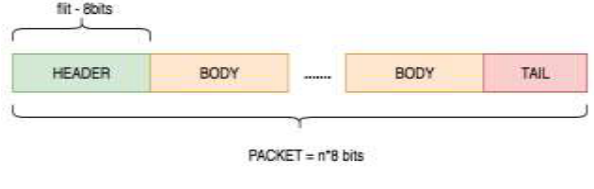
Figure 2. Wormhole Packet Format